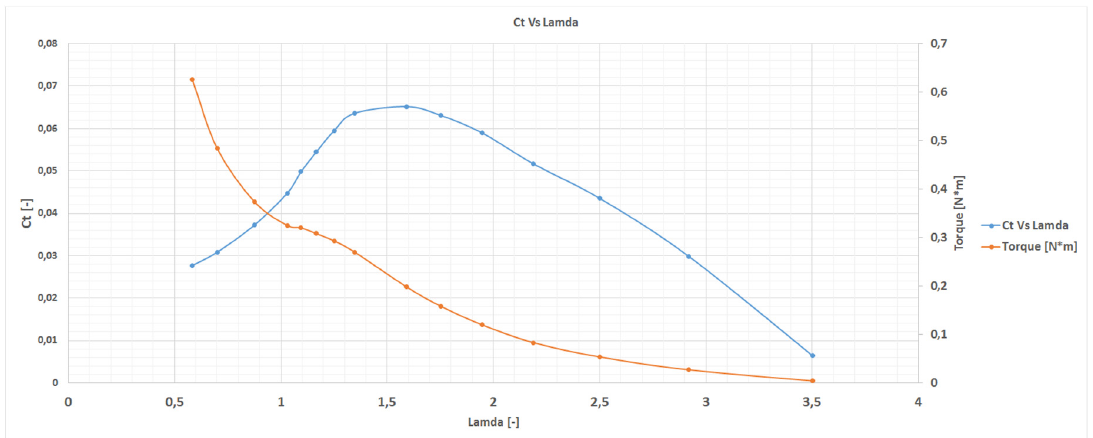
Figure 16. Ct vs TRS for Machigua’s seed. 15° pitch angle.